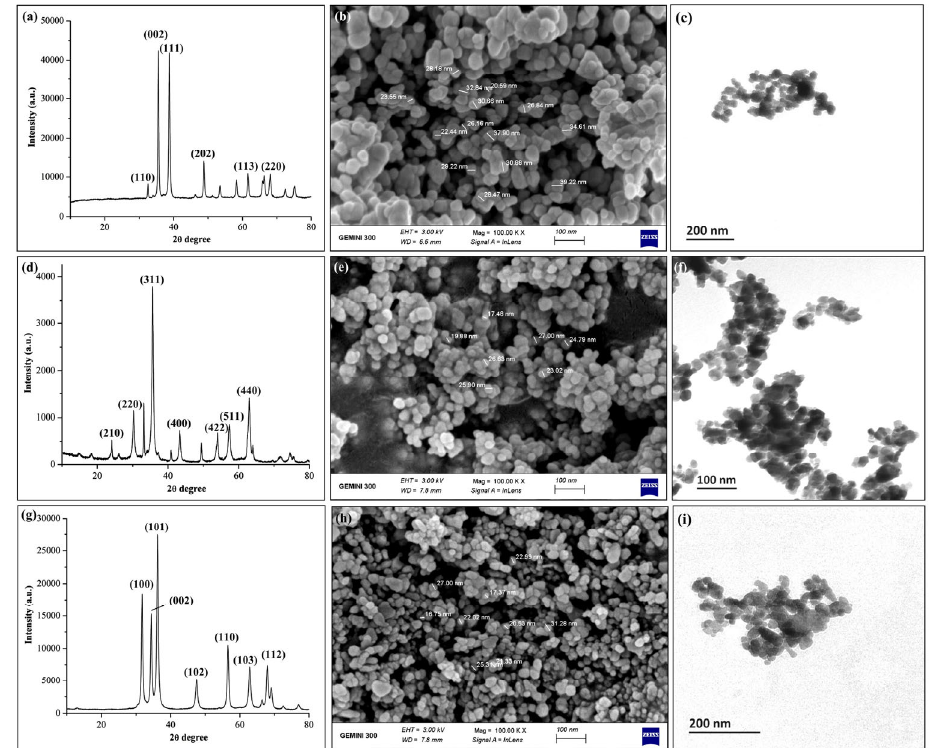
Figure 1. Characterization of three metal oxide nanoparticles (FeO, ZnO and CuO) using XRD spectral analysis ( a ) FeO, ( d ) ZnO and ( g ) CuO. Scanning electron micrographs ( b ) FeO, ( e ) ZnO and ( h ) CuO [scale bar = 100 nm]. Transmission electron micrographs ( c ) FeO, ( f ) ZnO and ( i ) CuO [scale bar = 100–200 nm].